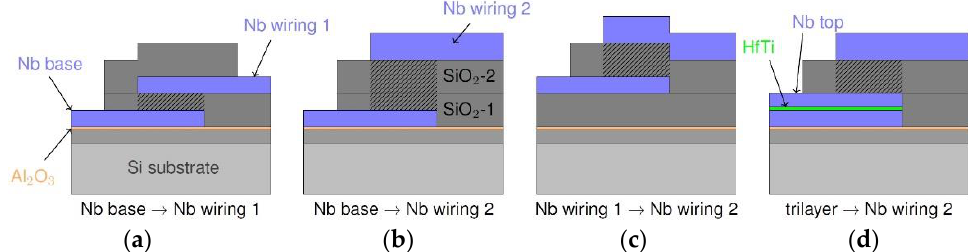
Figure 6. Layer scheme of the different types of parallel-plate capacitors. The plates of capacitors are in all three independent layers of Nb ( a – c ) as well as in the trilayer ( d ), and they are separated by SiO 2 as the dielectric layer. The hatched area represents the volume between the plates.